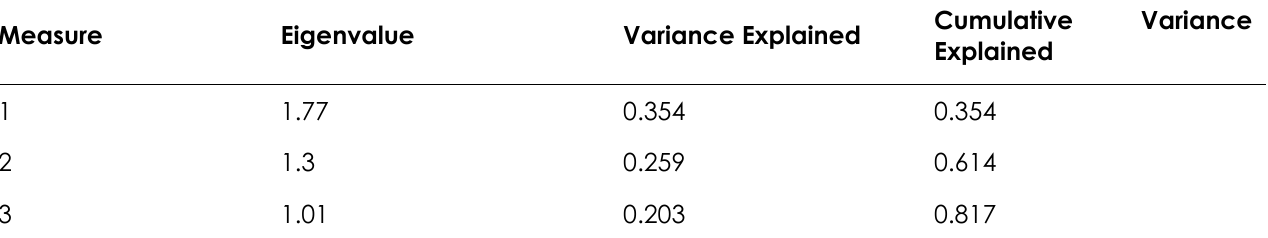
Table 5. Explanation of